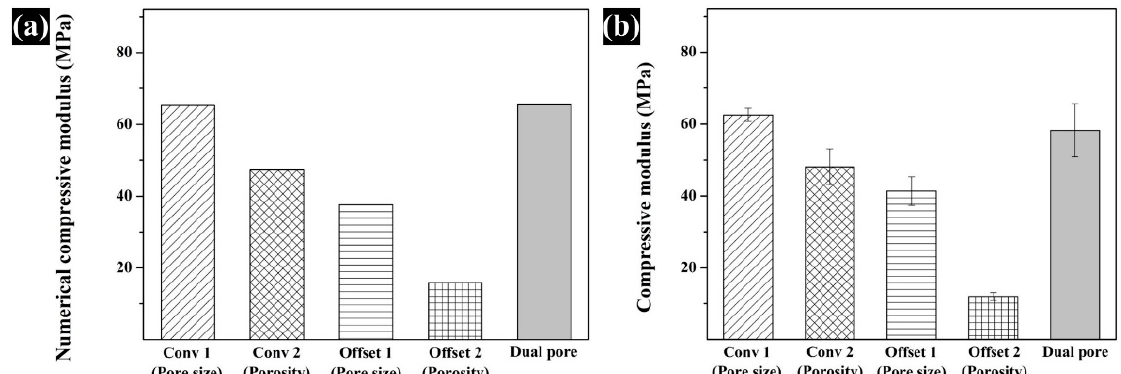
Figure 6. Comparison of the ( a ) numerical and ( b ) experimental compressive modulus for the fabricated scaffolds.